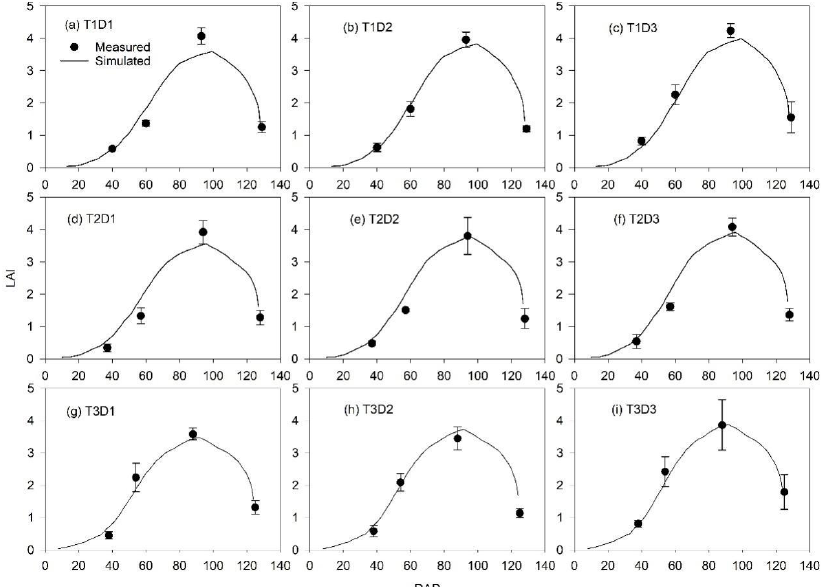
replicates. Broken line, regression line; solid line, 1:1 line. ○ represents T1, □ represents T2, △ represents T3; red represents D1, pink represents D2, blue represents D3.